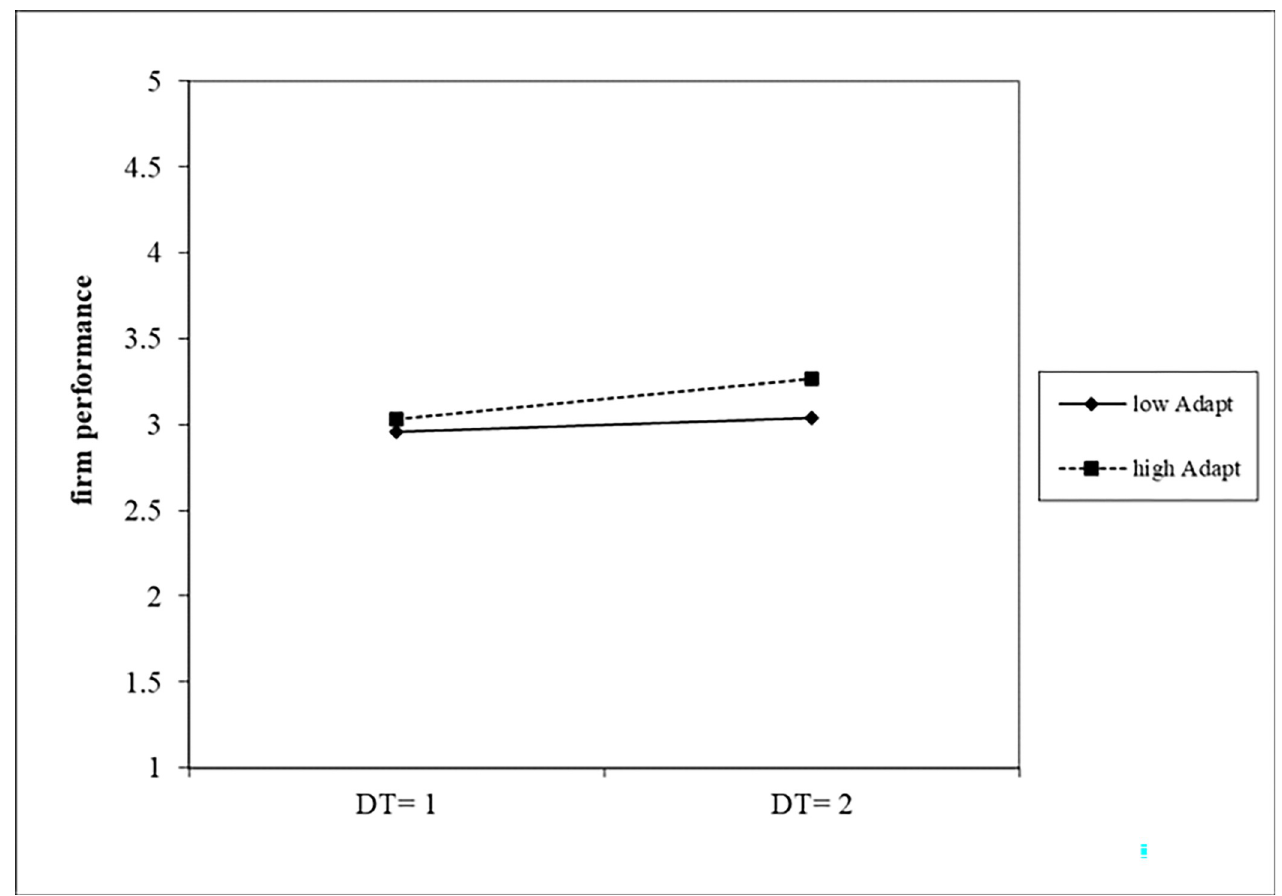
Fig 6. The moderating effect of adaptive capability on firm